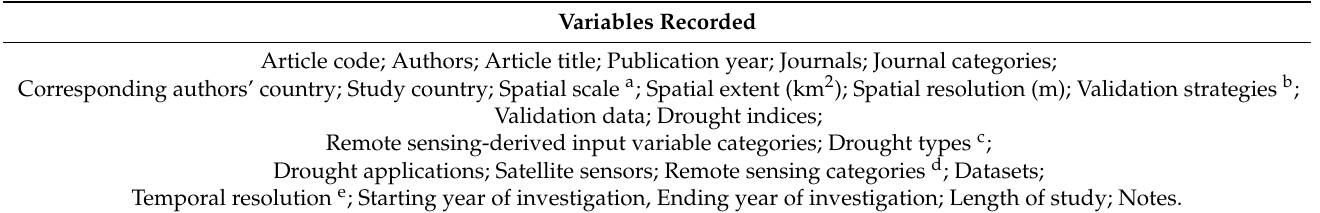
Table 2. A list of relevant variables used to derive the systematic plots and tables in this review. Variables